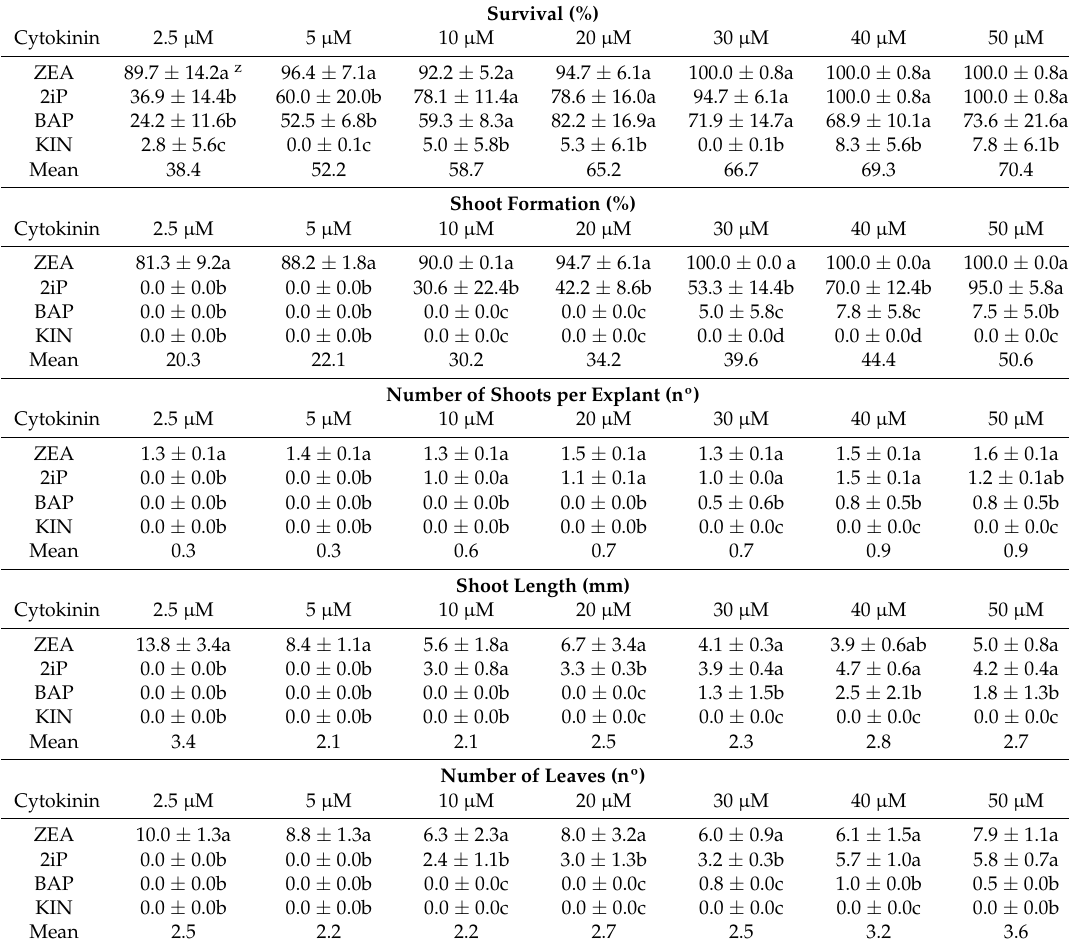
Table 4. Experiment 1, treatments with four cytokinins at different concentrations, showing mean values of survival (%), shoot formation (%), number of shoots (nº), length of shoot (mm), and number of leaves (n) in initial in vitro shoot culture of ‘Delite’ rabbiteye